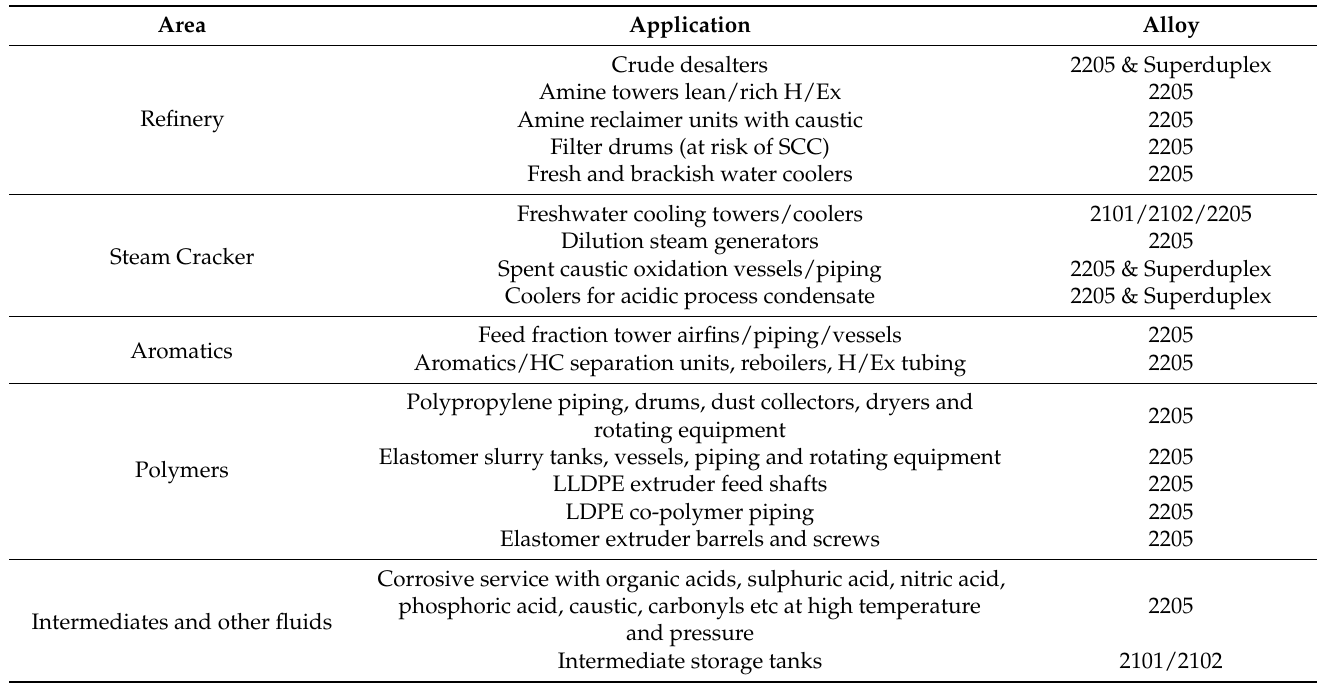
Table 6. Examples of the uses of duplex stainless steels in refineries and petrochemical plants [9]. SCC: stress corrosion cracking.